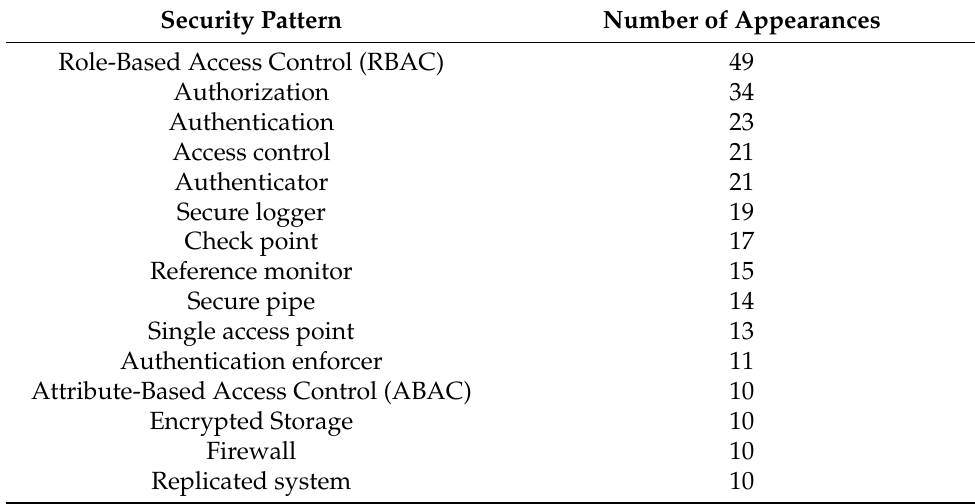
Table 2. Major security patterns mentioned in at least ten papers (adopted from [247] with updates of numbers and